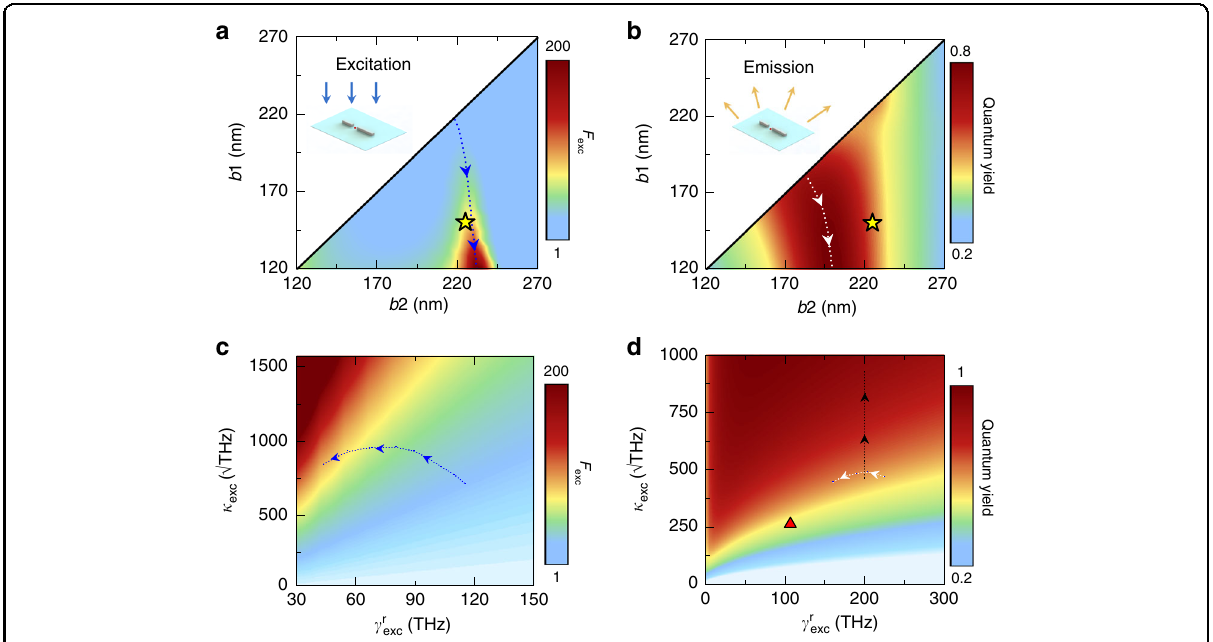
Fig. 4 Phase diagrams and CMT analyses of the molecule-antenna system. Numerically computed with FEM simulations a excitation enhancement (F exc , calculated at 633nm) and b quantum yield (calculated at 1050nm) of the asymmetric antennas versus bar lengths b 1 and b 2 . c Color ffiffiffiffiffiffiffiffi p ¼ 2 : 3 ¼ 7 : 6THz, and the blue with other CMT parameters fi xed as: d 0 THz , γ i map represents CMT-computed F exc (at 633nm) versus κ exc and γ r exc exc exc dashed line describes the evolution of those antennas located on the blue line in a . d Color map represents CMT-computed quantum yield (at 1050nm) with other CMT parameters fi xed as ∼ γ nr = 272 THz, γ emi = 1.3 THz, the white dashed line describes the evolution on those antennas versus κ exc and γ r exc located on the white dashed line in b , the black dashed line represents a series of antennas with gap distance decreasing from 80nm to 10nm and the red triangle represents an undesigned symmetric antenna (see Sec. 8 in SI for their geometric and CMT